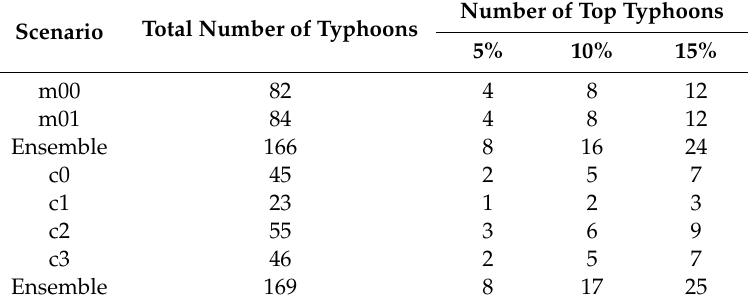
Table 1. The total number of typhoons and number of top 5%, 10%, and 15% typhoons in each climate change scenario and